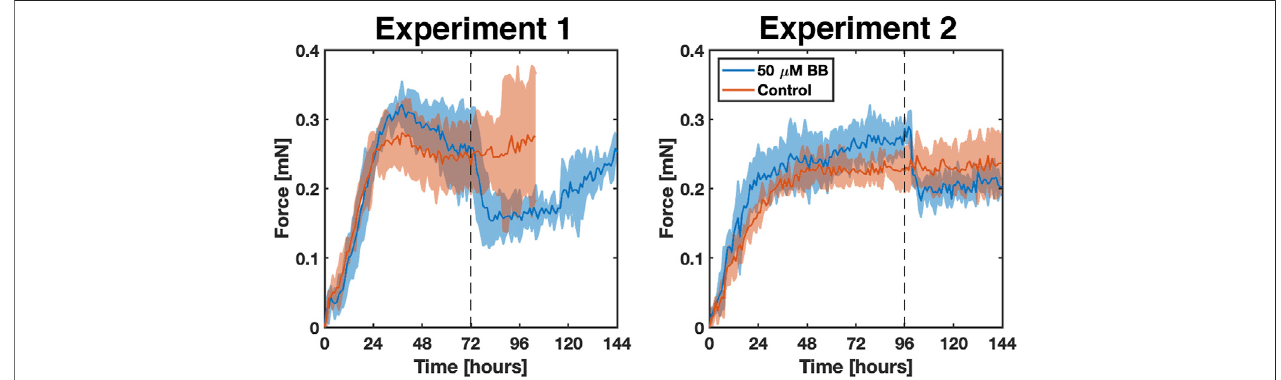
FIGURE 5 | Two experiments comparing the response and reproducibility of the bioreactor systems over 6 days in the presence (blue) and absence (red) of blebbistatin. Solid lines indicate the average of n = 3 replicates. The shaded areas correspond to the standard deviation. The grey dotted line marks the time at which